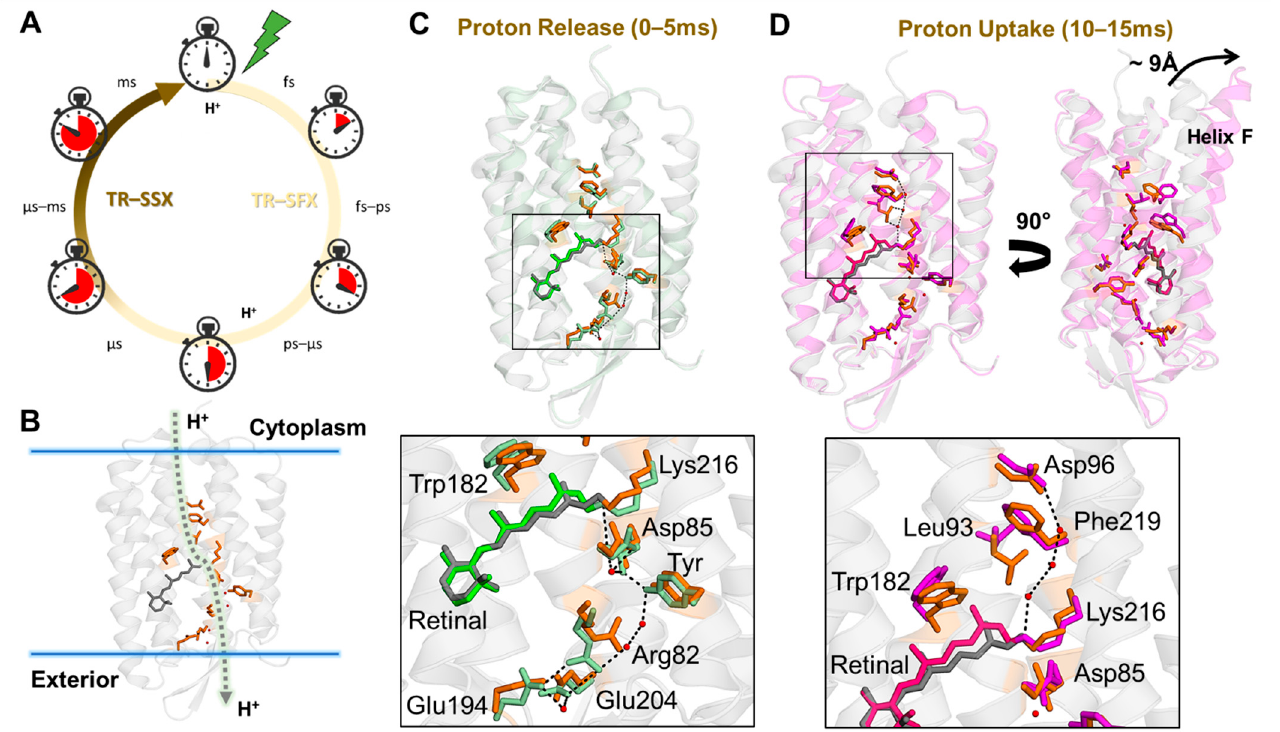
Figure 1. TR-SSX experiments for bR with viscous jets. ( A ) Proton pumping photocycle in bR with the relevant time domains for the individual steps. ( B ) Overview of the three principal steps in the photo cycle of bR. Structure of bR highlighting the key residues that participate in proton exchange from the cytoplasm to the exterior of the cell. Dashed arrow indicates the proton-transfer steps between charged residues. ( C ) Proton released step captured at 0–5 ms timepoint shows the rearrangements occurring at the necessary for proton release. The dark state is shown in orange and the closed state (0 to 5 ms) is shown in green. The red arrows indicate the direction of proton transfer reaction. ( D ) Proton uptake step captured at 10 to 15 ms timepoints in which the opening of the hydrophobic barrier between the primary proton donor Asp96 to the Shiff Base. The dark state is shown in orange and the open state (10 to 15 ms) is shown in pink. The conformational changes are accompanied by network of three water molecules (red spheres). The red arrows indicate the direction of proton transfer reaction. The displacement of about 9Å occurring on the cytoplasmic side at the end of helix F is also shown.